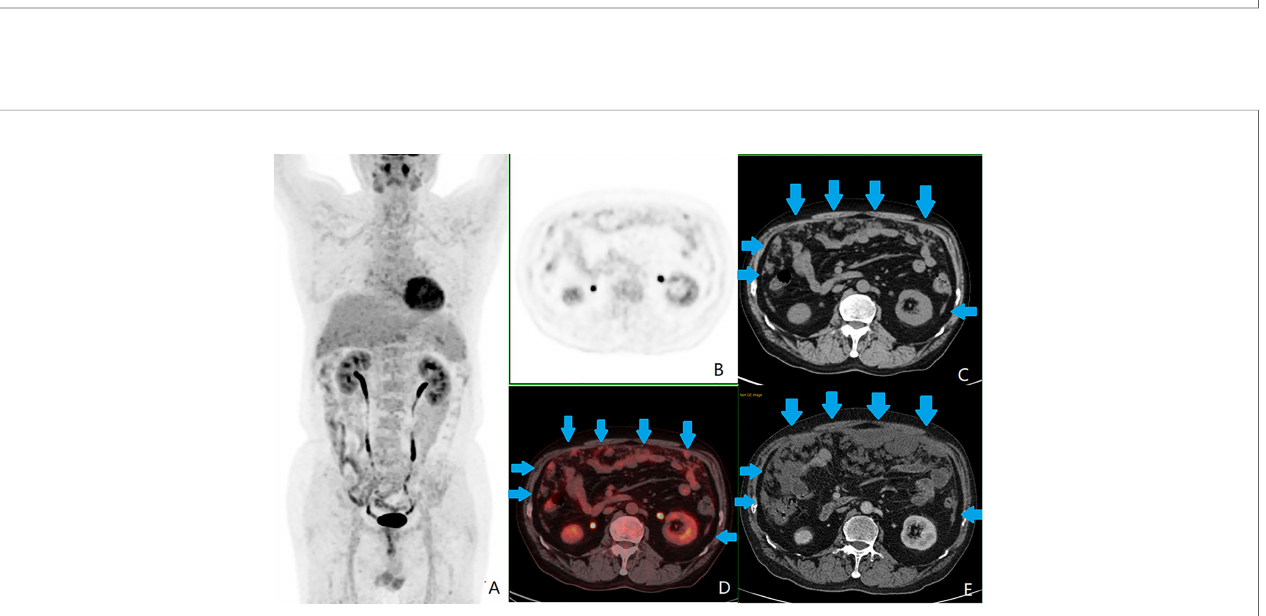
FIGURE 4 | A patient with colorectal peritoneal carcinomatosis (CRPC), male, 68 years old, with mucinous adenocarcinoma of the appendix. (A) The positron emission tomography (PET) 3D-MIP image; (B) PET cross-sectional image; (C, E) computed tomography (CT) cross-sectional image; (D) PET/CT fusion cross- sectional image; (A – D) the fi rst 18 F- fl uorodeoxyglucose PET/CT examination on October 11, 2016, which showed CRPC distributed in zones 0 ([lesion size] LS-2), 1 (LS-2), 2 (LS-2), 3 (LS-2), 4 (LS-2), 5 (LS-2), 6 (LS-2), 7 (LS-2), and 8 (LS-2), as shown by the blue arrow in images (C, D) . This patient had a peritoneal cancer index (PCI) score of 18. The largest lesion was located in the umbilical region (zone 0), measuring approximately 3.9 cm, with a standardized uptake maximum value of 4.8 g/ml with a small amount of seroperitoneum. (E) Contrast-enhanced abdominal and pelvic CT examination on September 14, 2019, showed signi fi cant progression of CRPC, with a PCI score of